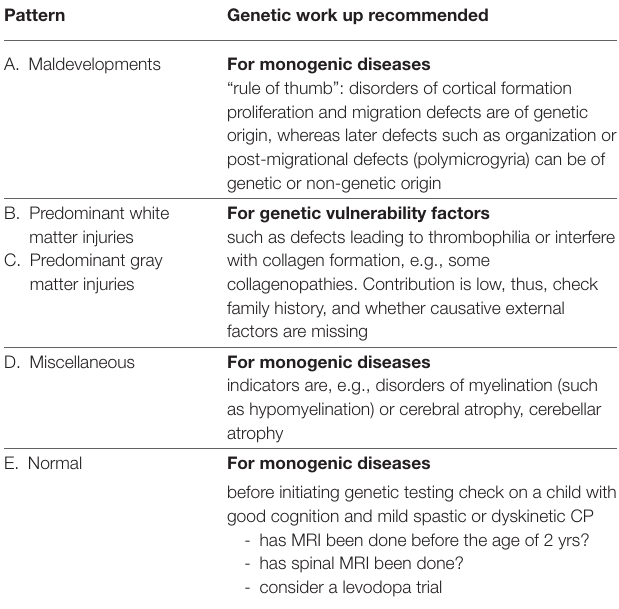
TABLE 1 | Recommendation for genetic work-up according to neuroimaging findings.